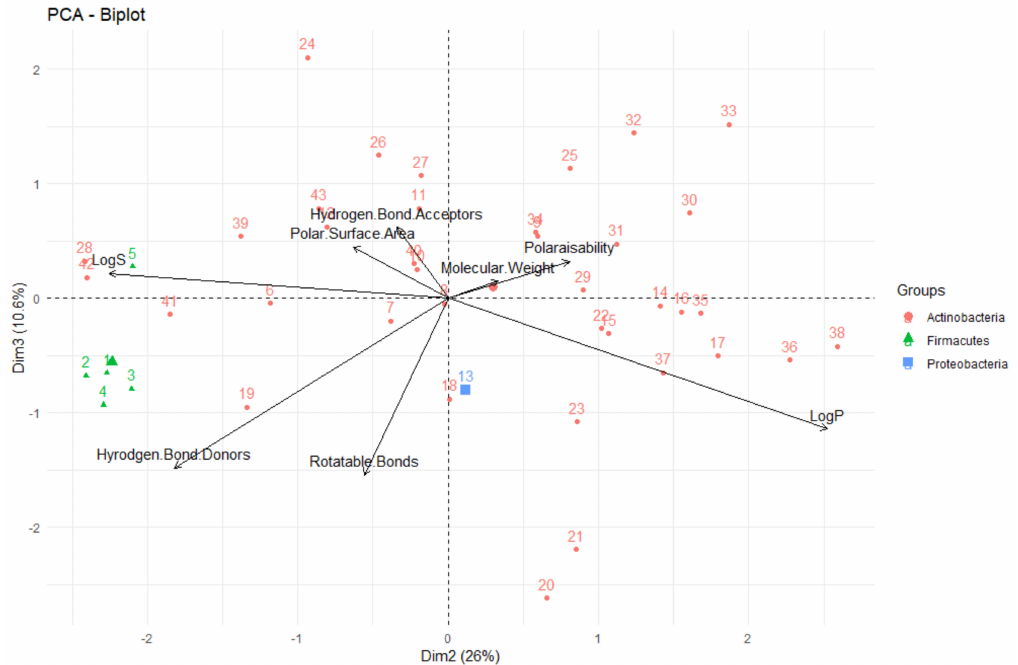
Figure 24. Biplot representing the PCA analysis on the compounds isolated from organisms in the Bacteria Kingdom and their molecular descriptors (PC2 vs. PC3). The arrows represent molecular descriptors and the direction in which they hold influence. Each point represents a